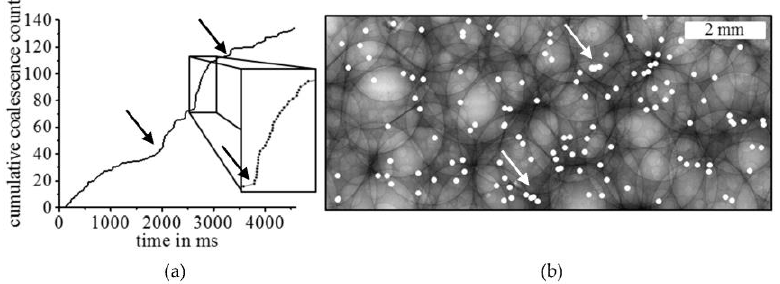
Figure 2. ( a ) Cumulative coalescence count vs. time with black arrows showing exemplary the starting point of three avalanches (one magnified as inset) and ( b ) coalescence map of a thixocast AlSi6Cu4 + 0.5 wt % TiH 2 liquid foam. White arrows indicate examples for close spatial distances between film ruptures. Each point in both images represents one single coalescence. A video of the whole sequence can be found online in the supplementary material (Video S1).